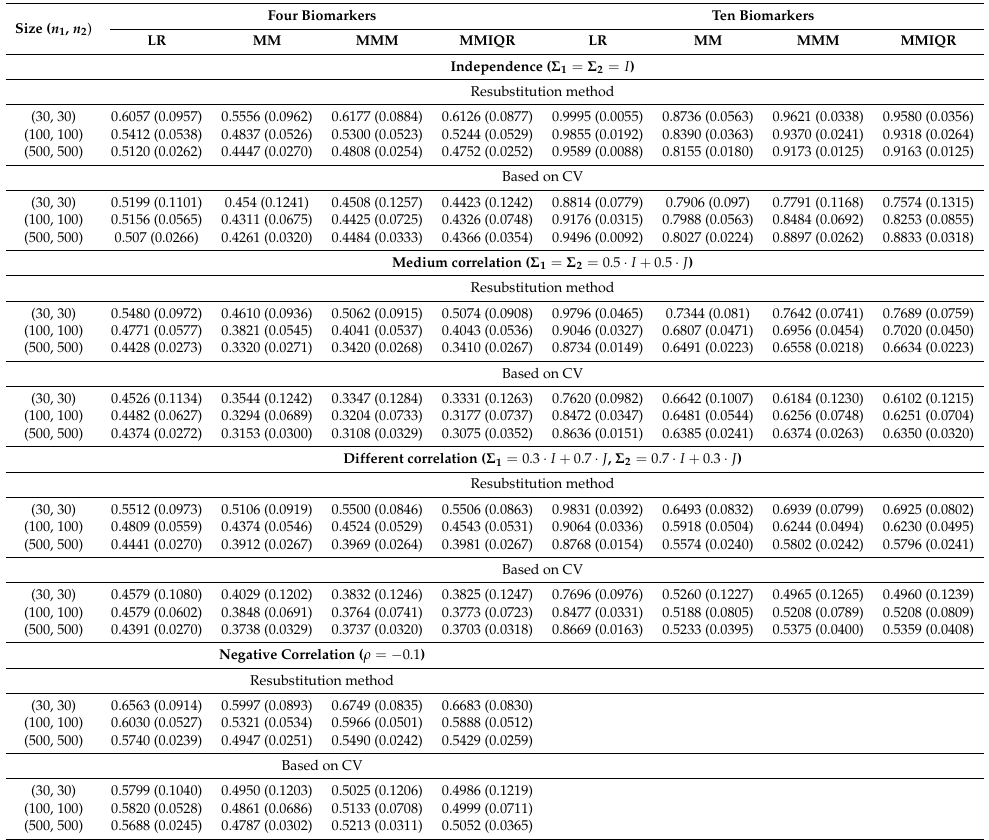
Table 1. Mean and standard deviation maximum Youden indices for 1000 random samples: normal distributions. Different means between